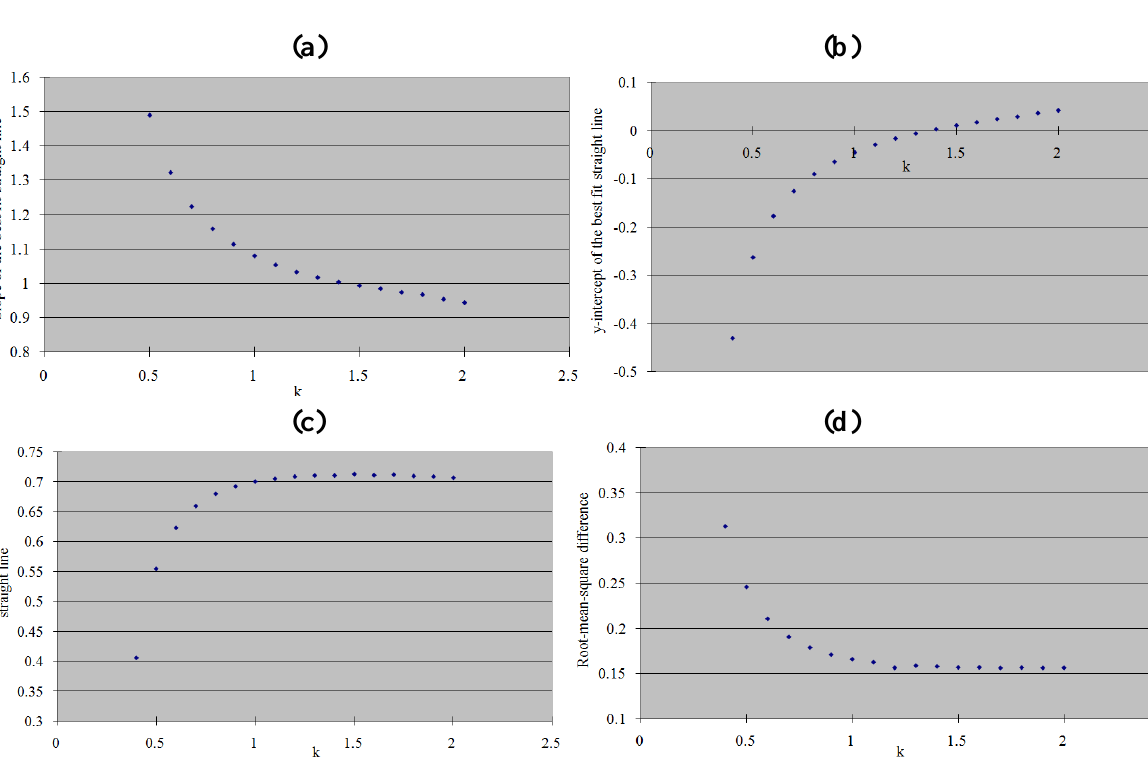
Figure 2. Variation of the following quantities with k: (a) slope, (b) y-intercept, and (c) correlation coefficient of the best fit straight line, and (d) root-mean-square difference, between AOD from LIDAR and AOD from sun photometer during the period October 2008 to January